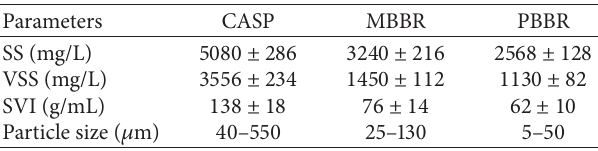
Table4:Theaveragewastesludgecharacteristicsofdifferentaerobic treatment